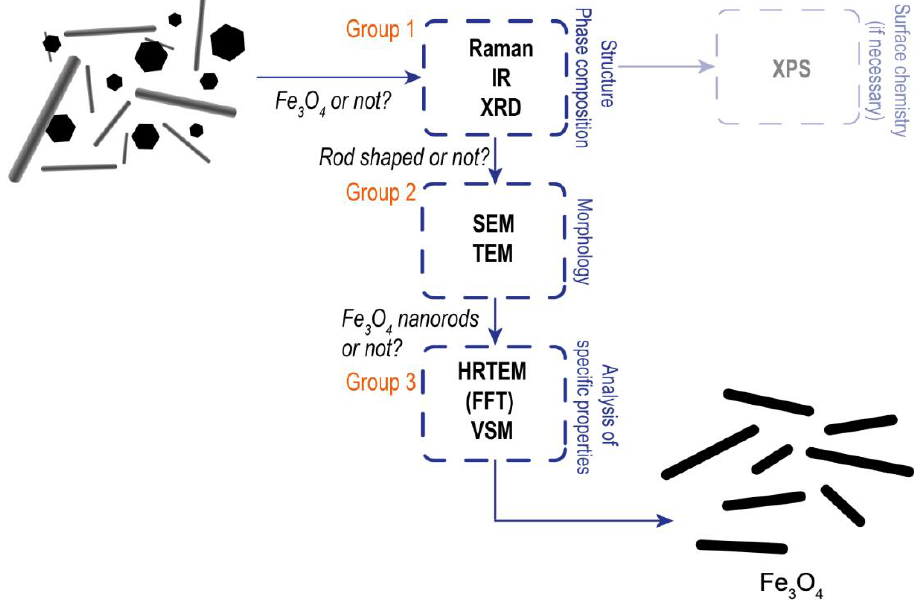
Figure 9. Methodological scheme of analysis of ANPs based on iron oxide or oxyhydroxide (an example for Fe 3 O 4 nanorods). Table 5. Characterization methods for a study of iron oxide and oxyhyroxide ANPs presented in some researches.